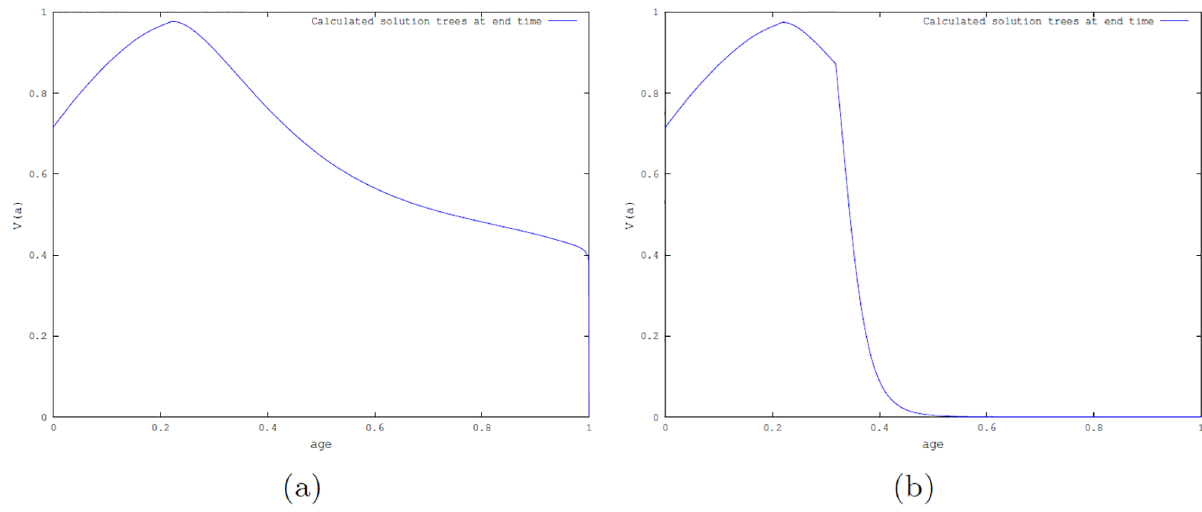
Fig 7. Number of trees at the end time resulting from simulation of the optimal control P3 with ω 1 = 1, ω 2 = .5, ω 3 = .1 and u population in the endemic state; (b): Beetle population in the epidemic state.